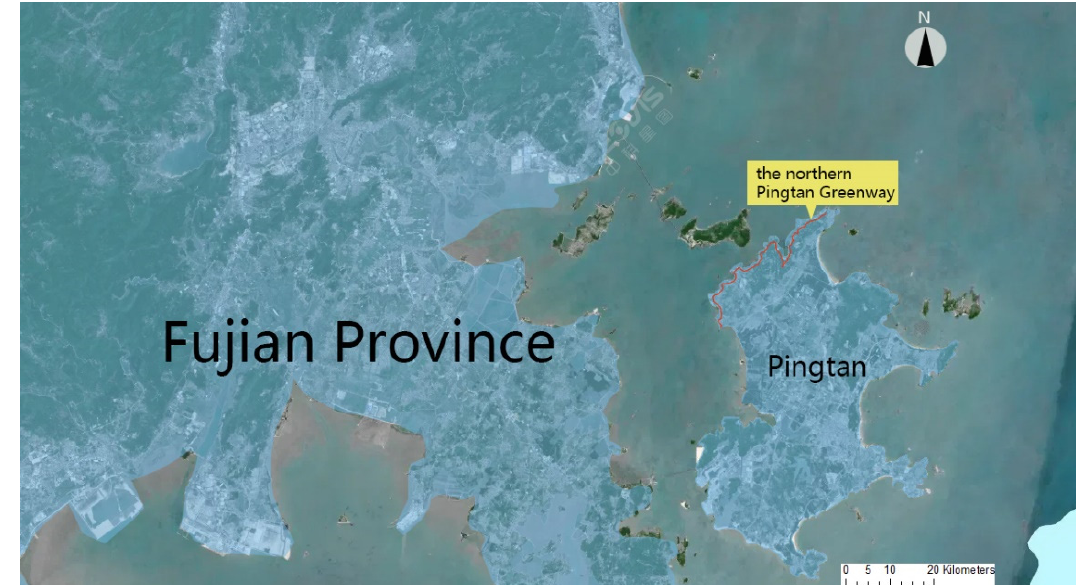
Figure 1. The northern Pingtan Greenway.